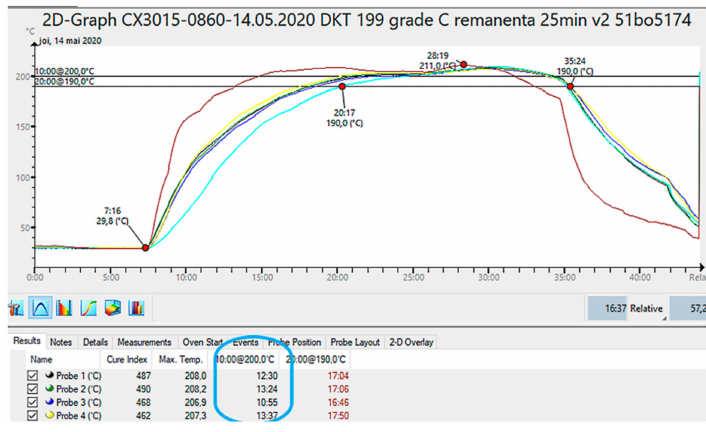
Figure 6. Temperature